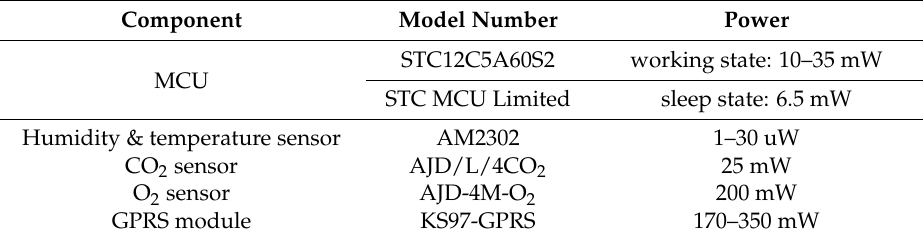
Table 4. The main component power consumption of the